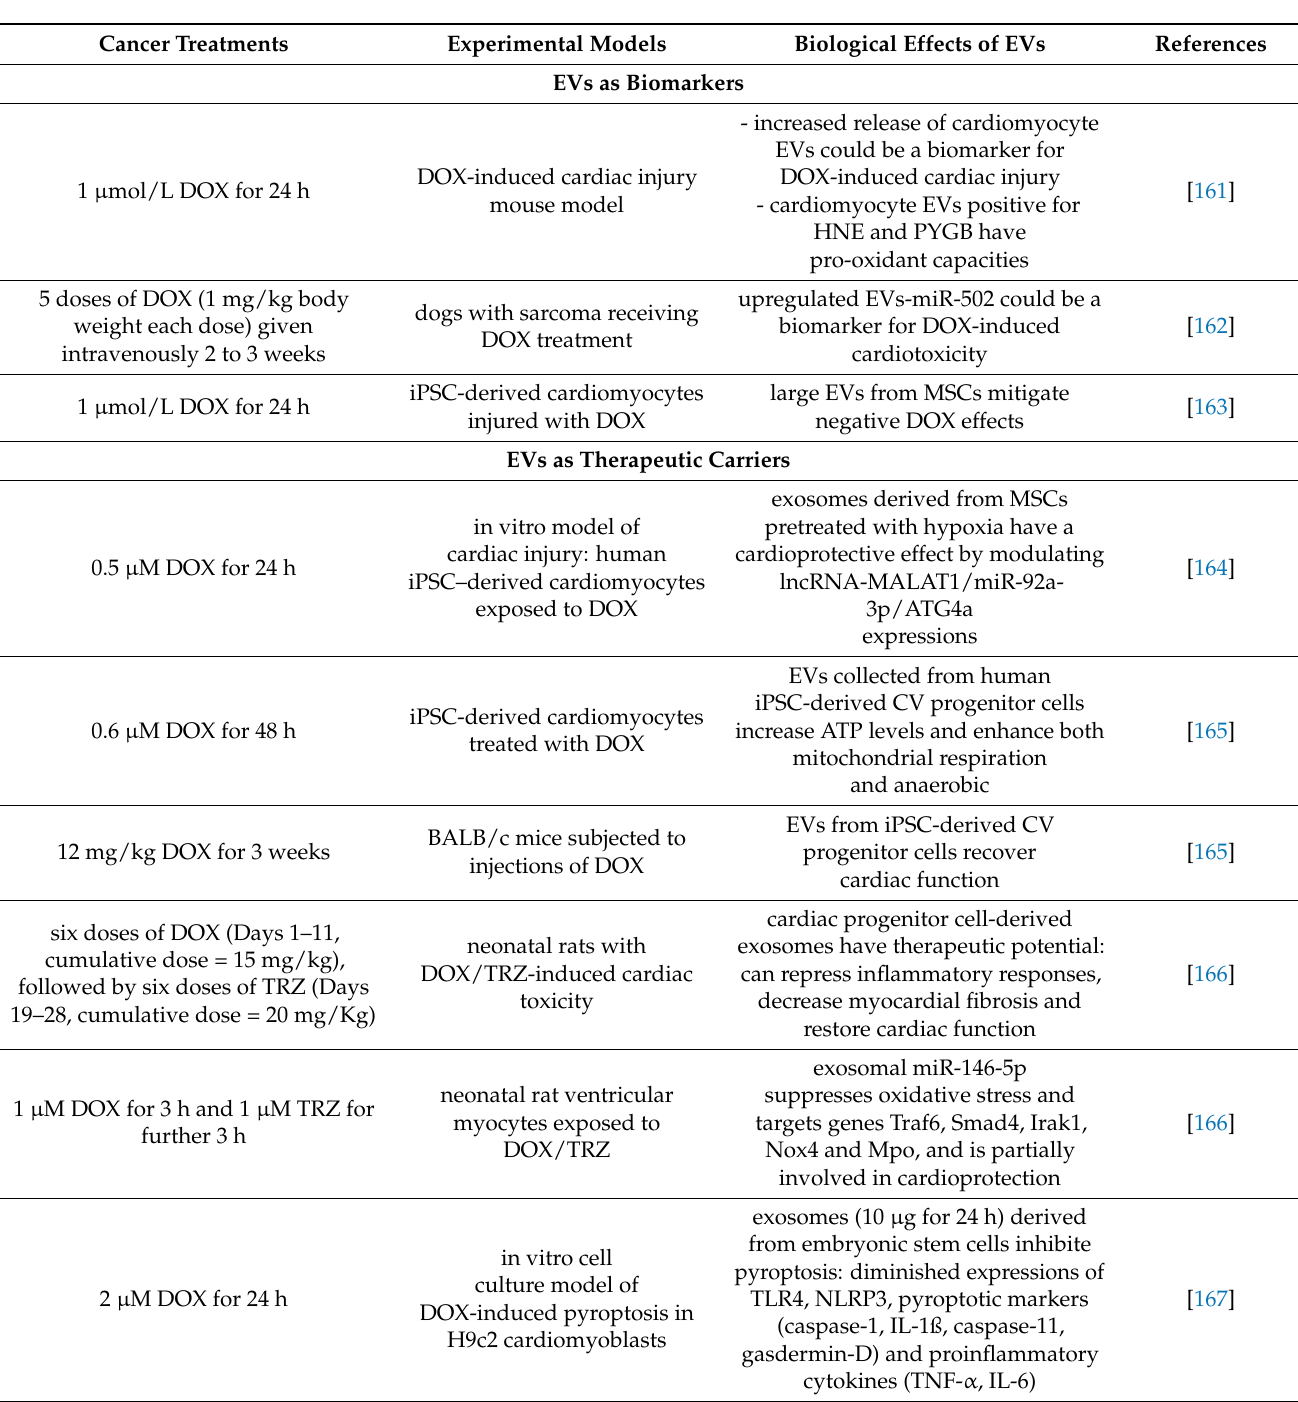
Table 3. EVs as biomarkers and therapeutic carriers in cardio-oncological experimental